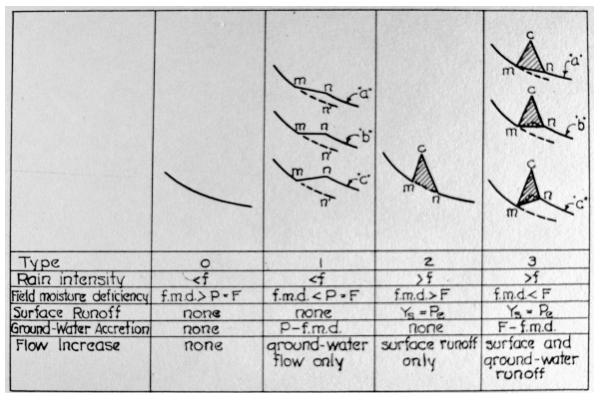
Figure 3. Classification of stream rises, with Type 3 showing how to separate groundwater runoff. Source: Horton